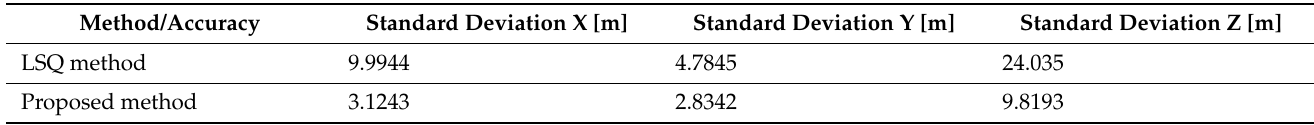
Table 4. Comparison of results of both LSQ and median filter methods for static records in an urbanized area.